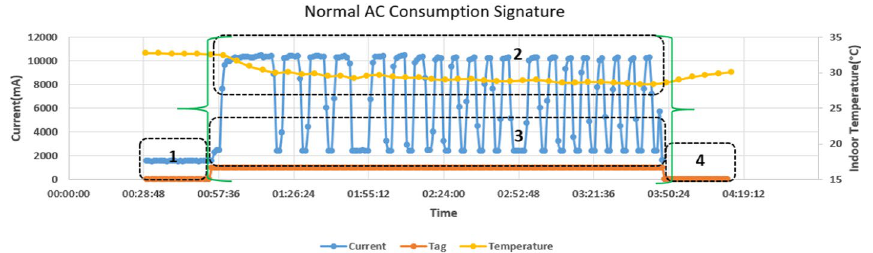
Fig. 7 Sample graph of identifying a fixed-speed compressor AC usage cycle